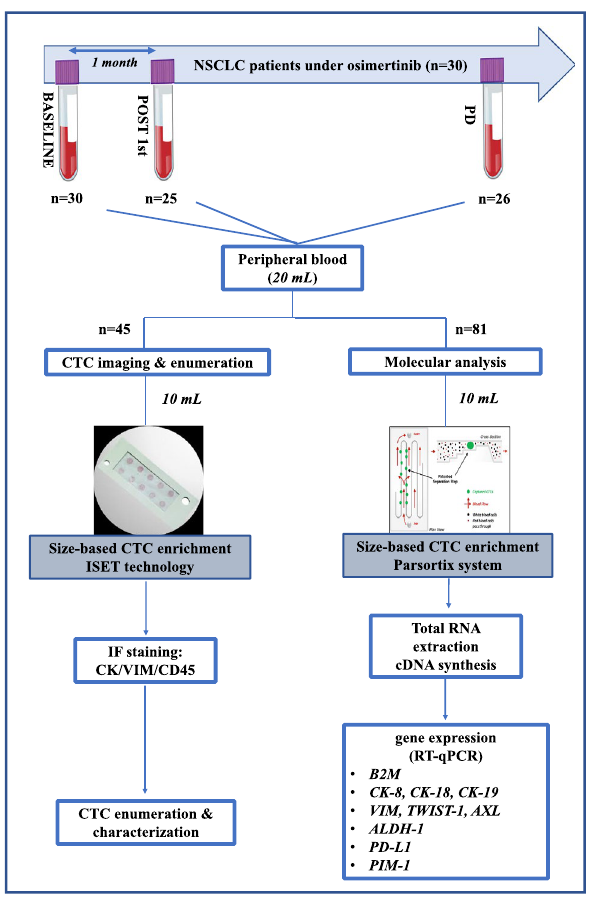
Figure 1. A schematic flowchart of the